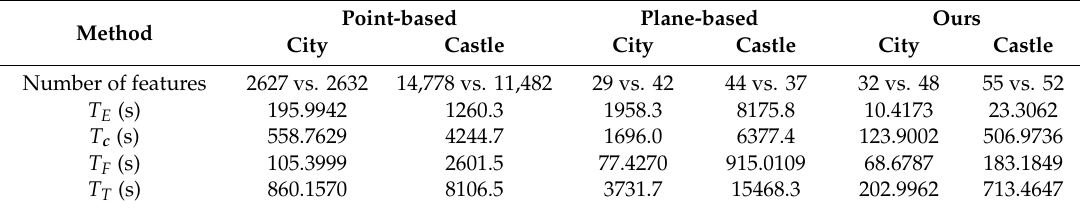
Table 4. The number of features and the time spent on each phase for the three methods on the outdoor dataset. T E denotes the time for feature extraction, T c denotes the time for coarse registration, T F denotes the time for fine registration, and T T denotes the total